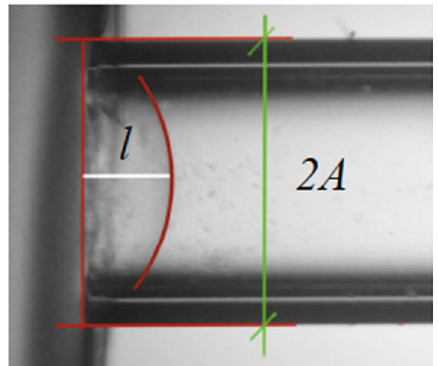
Figure 16. Example of the image analysis. l is the aspiration length and 2A is the external diameter (1 mm) of the glass pipette which is used as a reference by the MATLAB